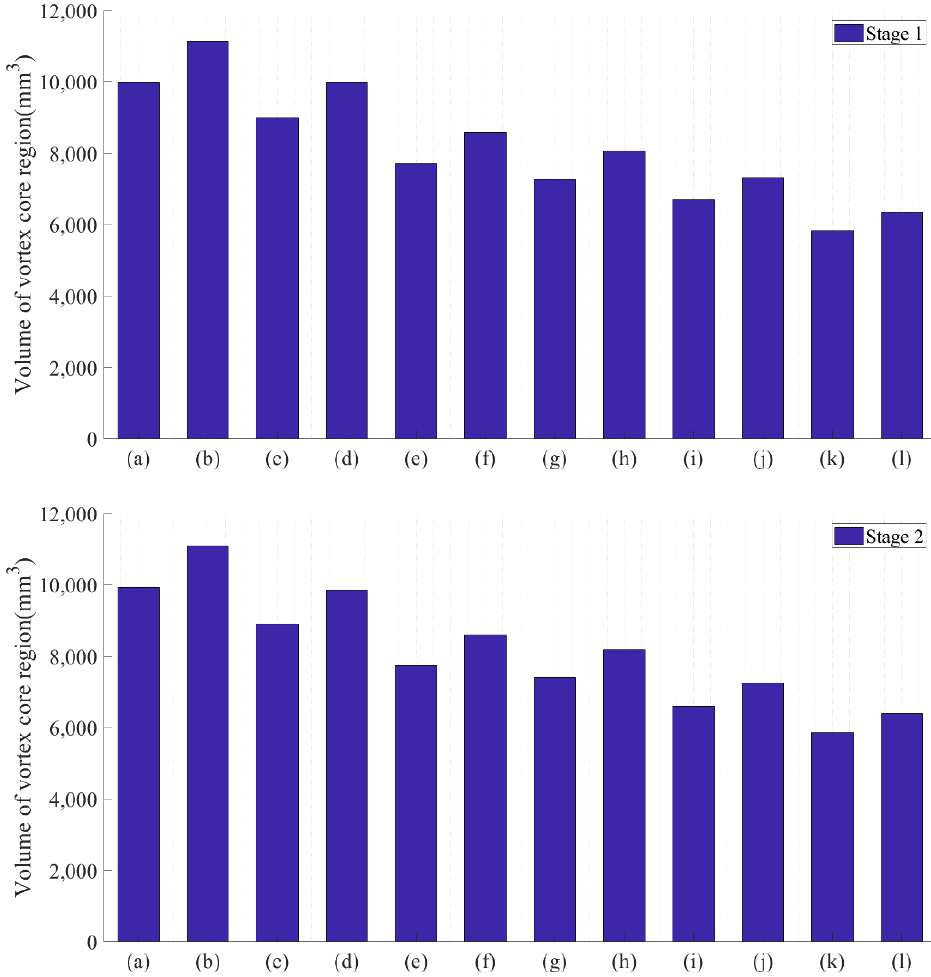
Figure 17. Volume comparison of vortex core area (instantaneous) of different side channel impellers at the same stage based on the DES model with or without curvature correction (a) Q4-NCC-P, (b) Q4-NCC-V, (c) Q4-CC-P, (d) Q4-CC-V, (e) Q8-NCC-P, (f) Q8-NCC-V, (g) Q8-CC-P, (h) Q8-CC-V, (i) Q12-NCC-P, (j) Q12-NCC-V, (k) Q12-CC-P, and (l) Q12-CC-V.